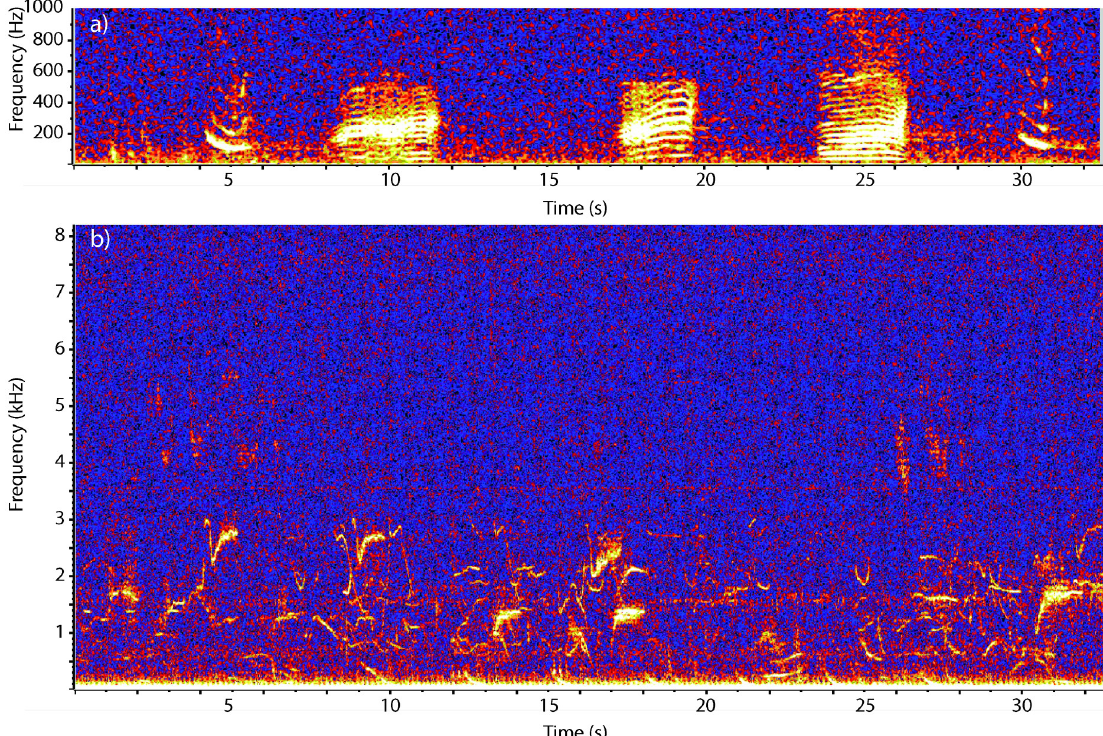
Fig 2. Spectrograms of characteristic bowhead and beluga whale signals. a) Five bowhead whale calls recorded on 11 July 2017 (FFT 2048, 50% overlap, Hann window). b) Beluga whale calls recorded on 4 May 2017 (FFT 1024, 50% overlap, Hann window). Note the different frequency axes for the two species’